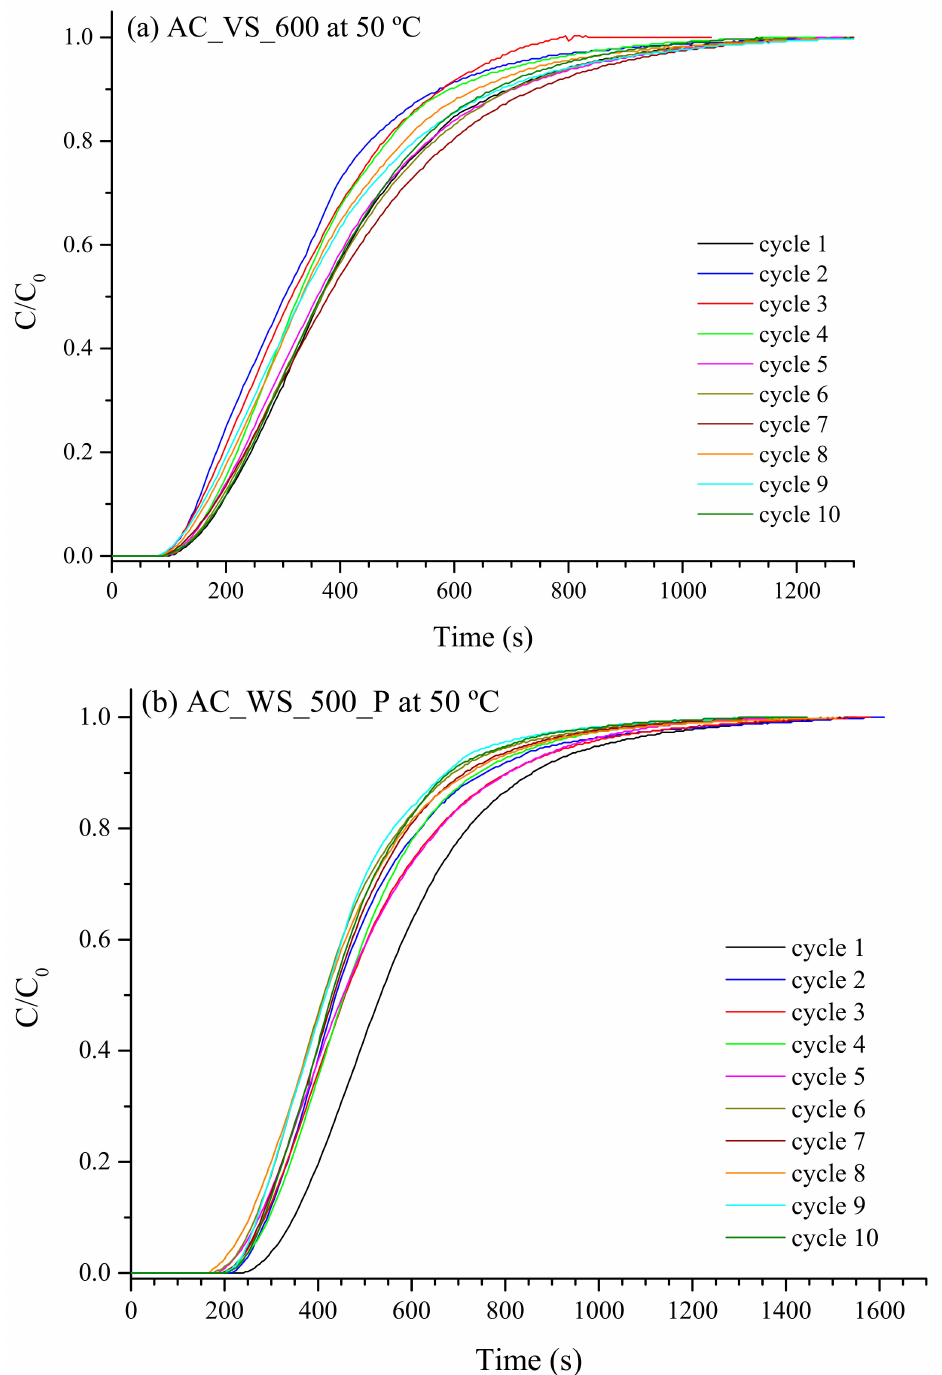
Figure 6. CO 2 breakthrough curves for ten consecutive cycles (adsorption temperature = 50 ◦ C) from a wet mixture of N 2 and CO 2 (with a CO 2 composition of 13.75–14.25 vol. %; relative humidity (RH) = 100%) using the AC_VS_600 ( a ) and AC_WS_500_P ( b ) materials.